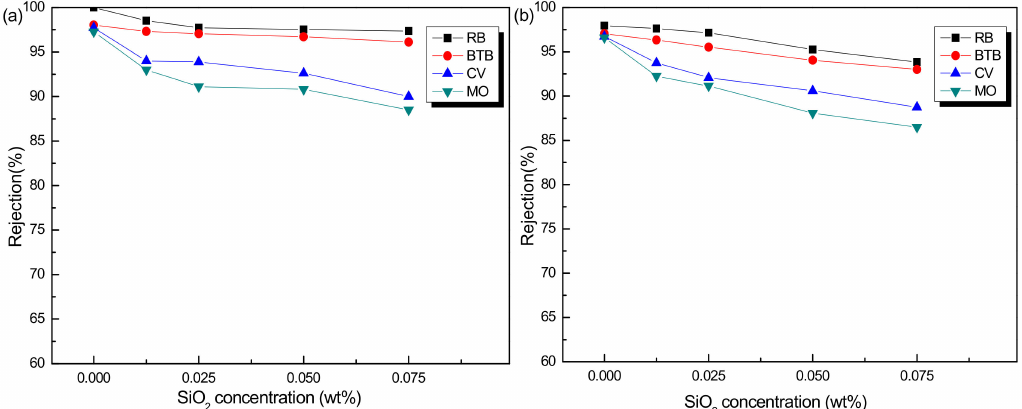
Figure 5. Effect of SiO 2 concentration on the PSf/PA-SiO 2 membranes, in terms of rejection for different dyes in ( a ) methanol solvent and ( b ) ethanol